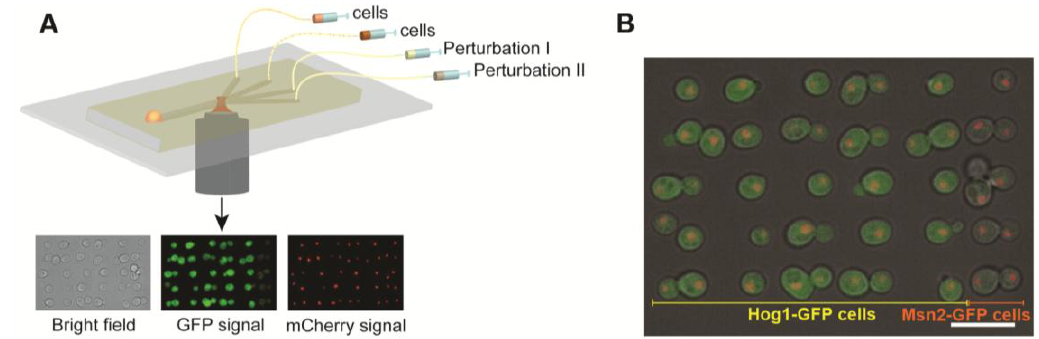
Figure 2. Schematic image of the setup in relation to the workflow. ( A ) The syringes filled with cells and substances are placed in a syringe pump. Cells are trapped by OT and positioned in an array within the microfluidic chamber. The cells and their reporter proteins are imaged in transmission light and fluorescent light while the pump flow rates are automatically controlled and altered; ( B ) a colored overlay of the bright field, GFP and mCherry images. Cells were actively placed in an array using the OT. In the four first columns, cells are expressing Hog1-GFP and in the rightmost column, control cells are instead expressing Msn2-GFP. The two cell types are visually distinguishable by the different GFP expression. Both cell types express the nucleic protein Nrd1-mCherry. The scale bar is 10